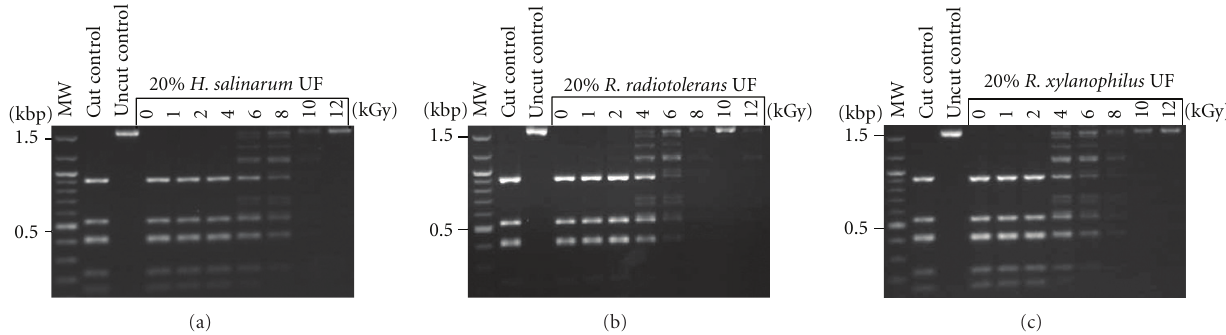
Figure 1: Protection of enzyme activity. The restriction enzyme Dde I was irradiated up to 12kGy in enzyme-free cell extracts (UFs) of H. salinarum , R. radiotolerans, and R. xylanophilus (diluted to 0.2x). Residual restriction enzyme activity was assayed by the digestion of pUC19 plasmid DNA; fragments were analyzed by agarose gel electrophoresis. The first lanes are molecular size ladders.